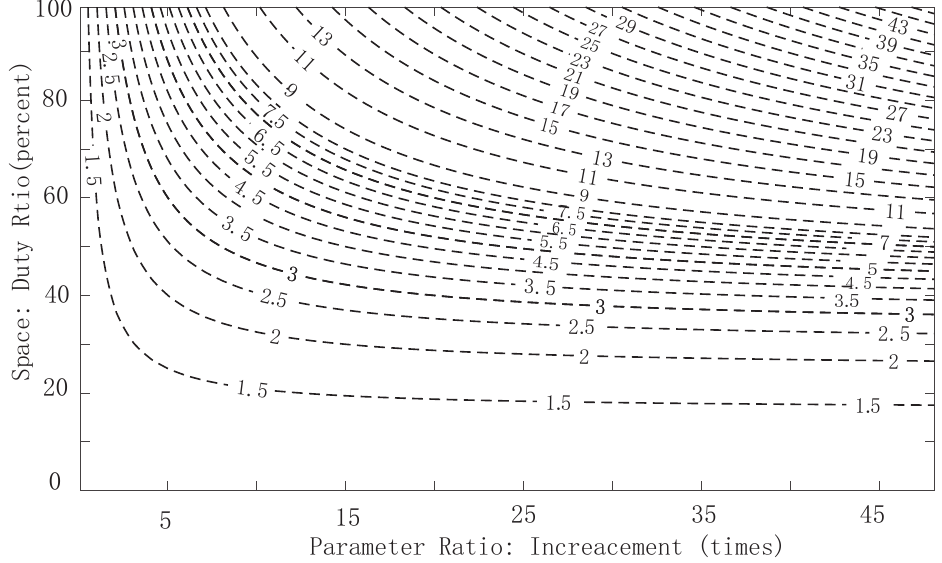
Figure 6. Contour lines for covariant values of effective relative permittivity tuned by spatial duty ratio and material doping